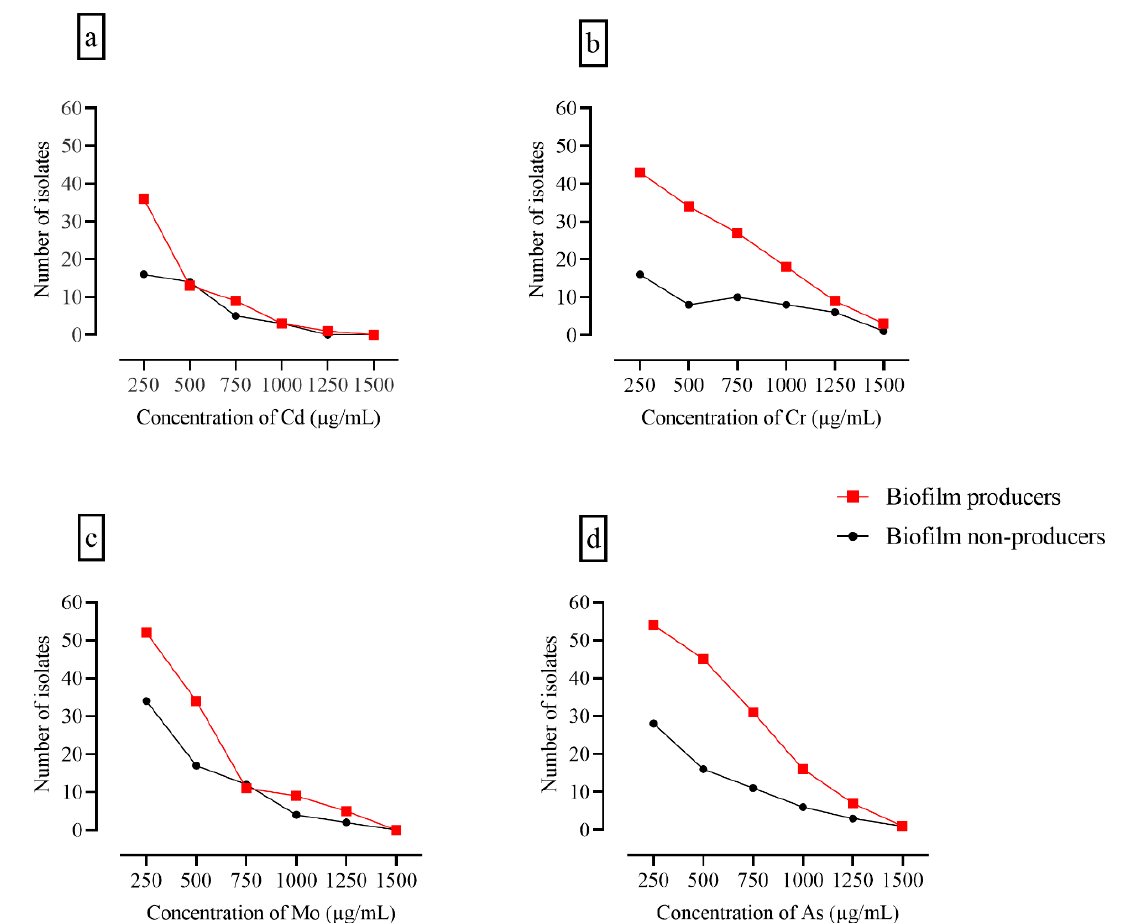
Figure 4. Heavy metal tolerance and biofilm formation. The panels show the heavy metal tolerance of biofilm producers and biofilm non-producers. The number of positive cultures of surviving biofilm producers and biofilm non-producers declined with increasing concentrations of; ( a ) Cd: cadmium chloride; ( b ) Cr: chromium oxide; ( c ) Mo: molybdenum oxide; and ( d ) As: arsenic chloride.